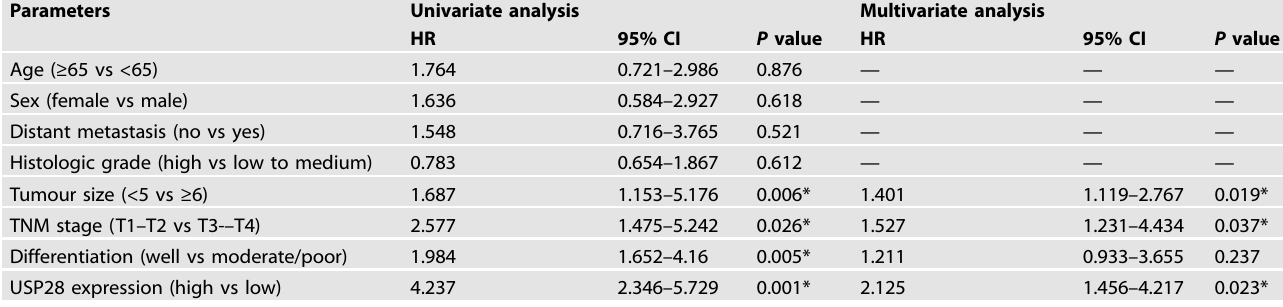
Table 2. Univariate and multivariate analyses of overall survival in PC patients.